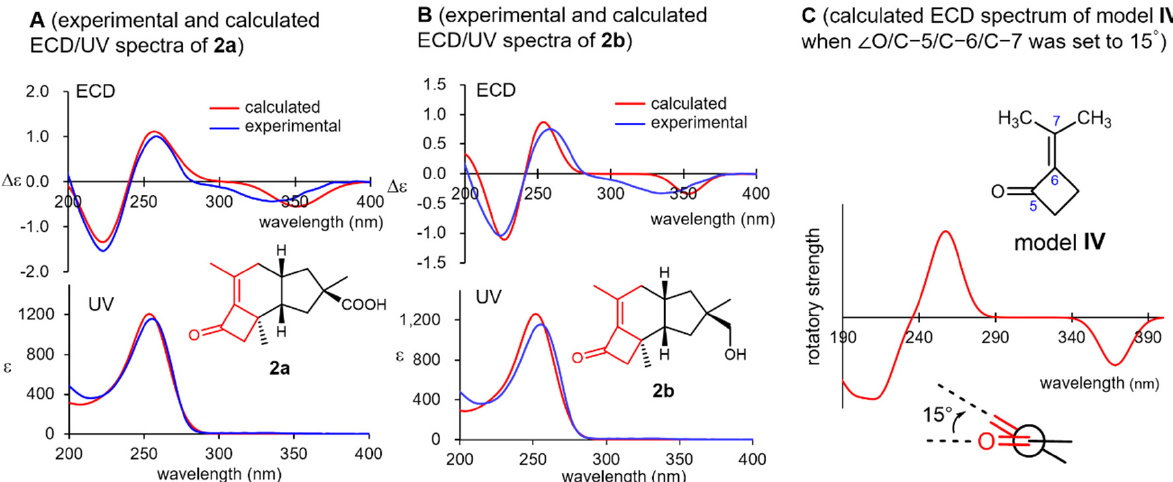
Figure 4 . Experimental and calculated ultraviolet/electronic circular dichroism (ECD) spectra of 2a (spectra A ) and 2b (spectra B ) and virtual ECD spectrum of model IV by setting the torsion ∠ O/C-5/C-6/C-7 to 15 ◦ (spectrum C ).